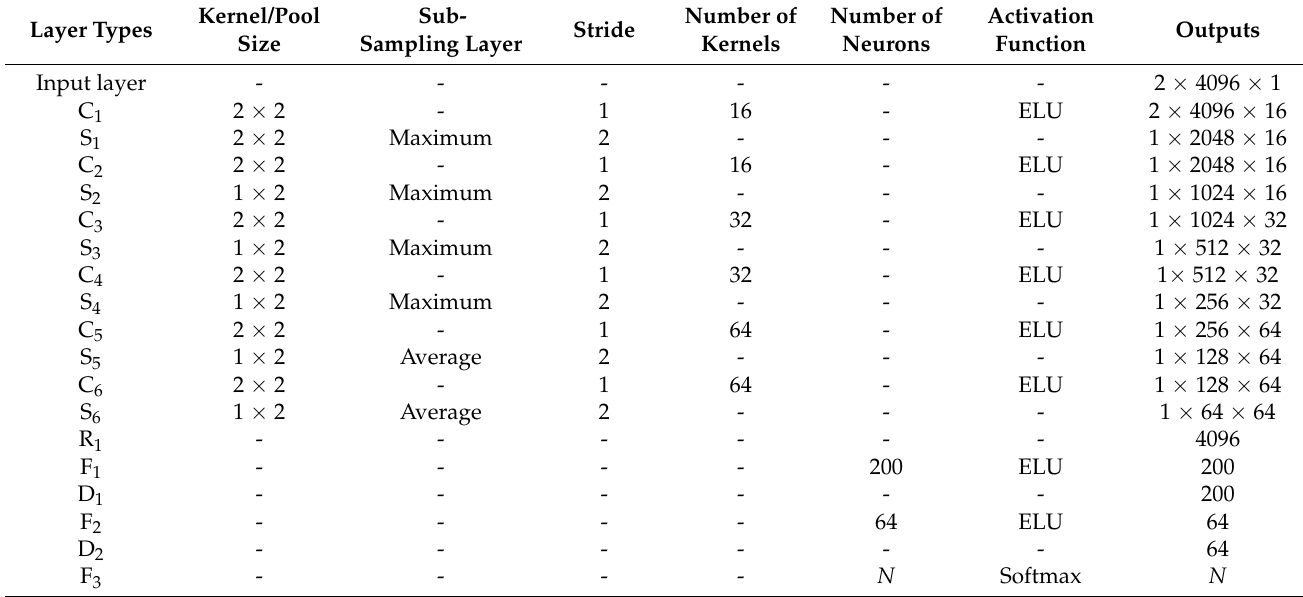
Table 1. Architecture of the proposed 2D-CNN model.